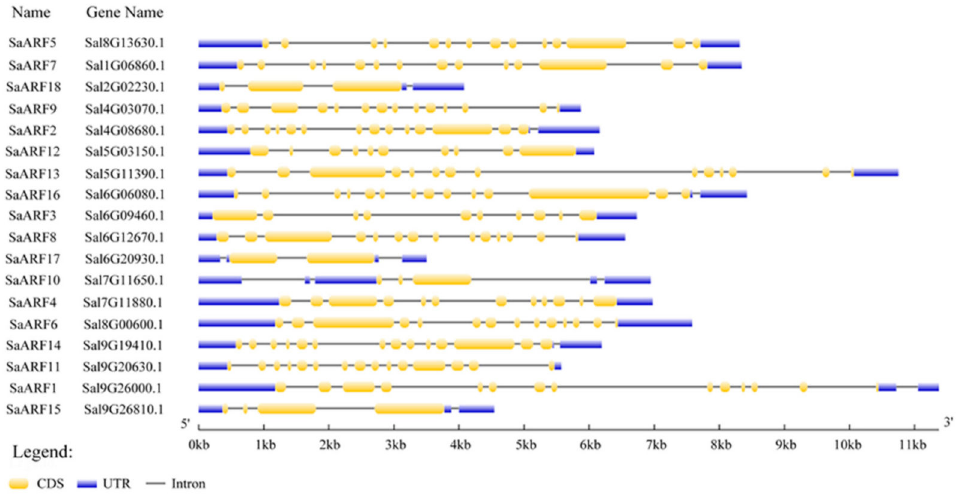
Figure 3. Genetic structure of the ARF gene in S. album . The value includes CDS, UTR, and intron. The yellow value is the CDS coding area, and the blue value is the UTR coding